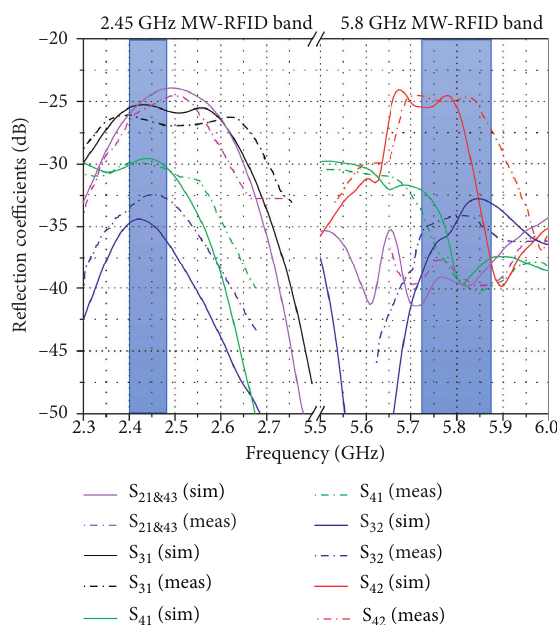
Figure 13: Simulated and measured magnitudes of S